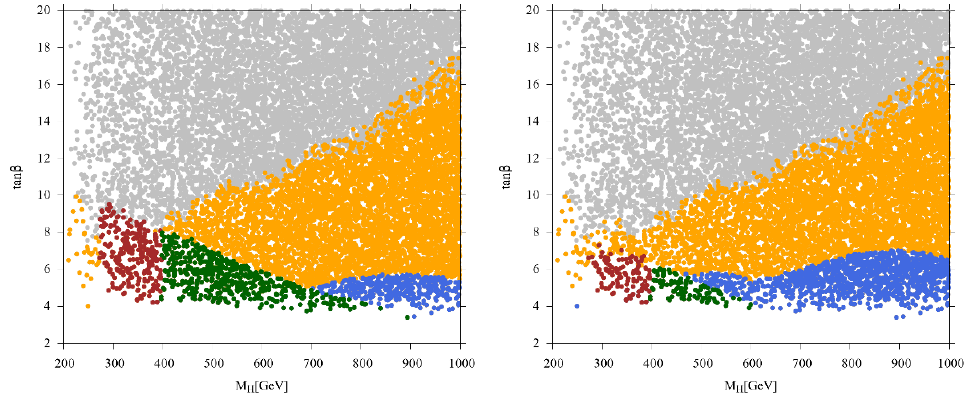
Figure 40 . Scatter plot in the m A tan (cid:12) plane showing the impact of the projected search limits (cid:0) derived in this study, for the case of HL-LHC. The orange and grey colored points represent the same color code of (cid:12)gure 38. The brown colored points are excluded by the 2 (cid:27) upper limits on (cid:27) ggH Br ( H hh ) Br ( h b (cid:22) b ) Br ( h (cid:13)(cid:13) ), derived in section 2.1, while the green colored (cid:2) ! (cid:2) ! (cid:2) ! points are excluded by the 2 (cid:27) upper limits on (cid:27) ggH Br ( H t (cid:22) t ) derived in section 3. Upper (cid:2) ! limits derived for the case of (cid:27) Br ( H=A (cid:28)(cid:28) ) (section 4) at 2 (cid:27) rule out the orange colored b (cid:22) bH=A (cid:2) ! points. The blue colored points represent the parameter space which would remain allowed after the HL-LHC run. The left and the right plots respectively show the exclusion at 2 (cid:27) and discovery reach at 5 (cid:27)